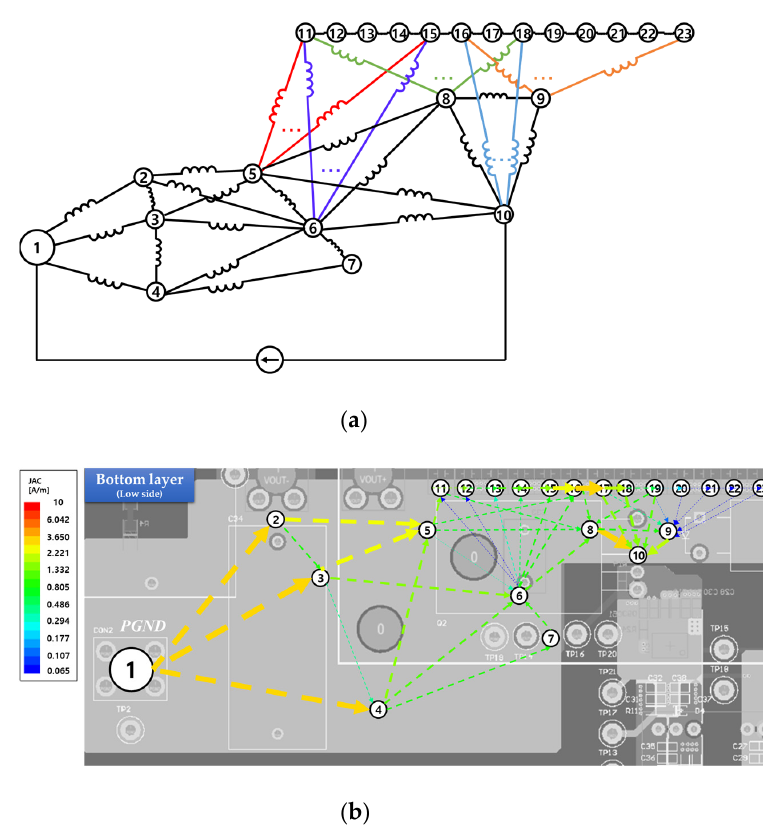
Figure 13. PSpice simulation at low side of bottom layer. ( a ) Circuit model. ( b ) Simulation